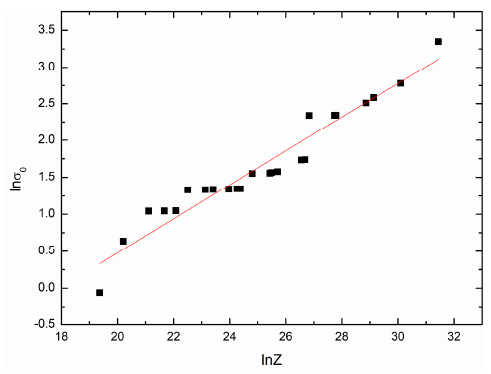
Figure 11. The relationship between ln σ 0 and ln Z